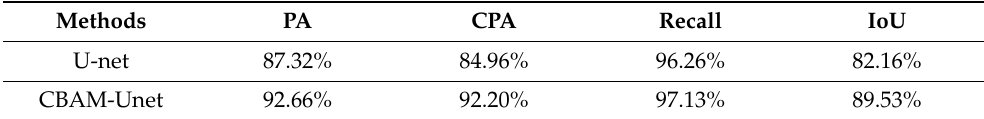
Table 3. Accuracy of crack detection.